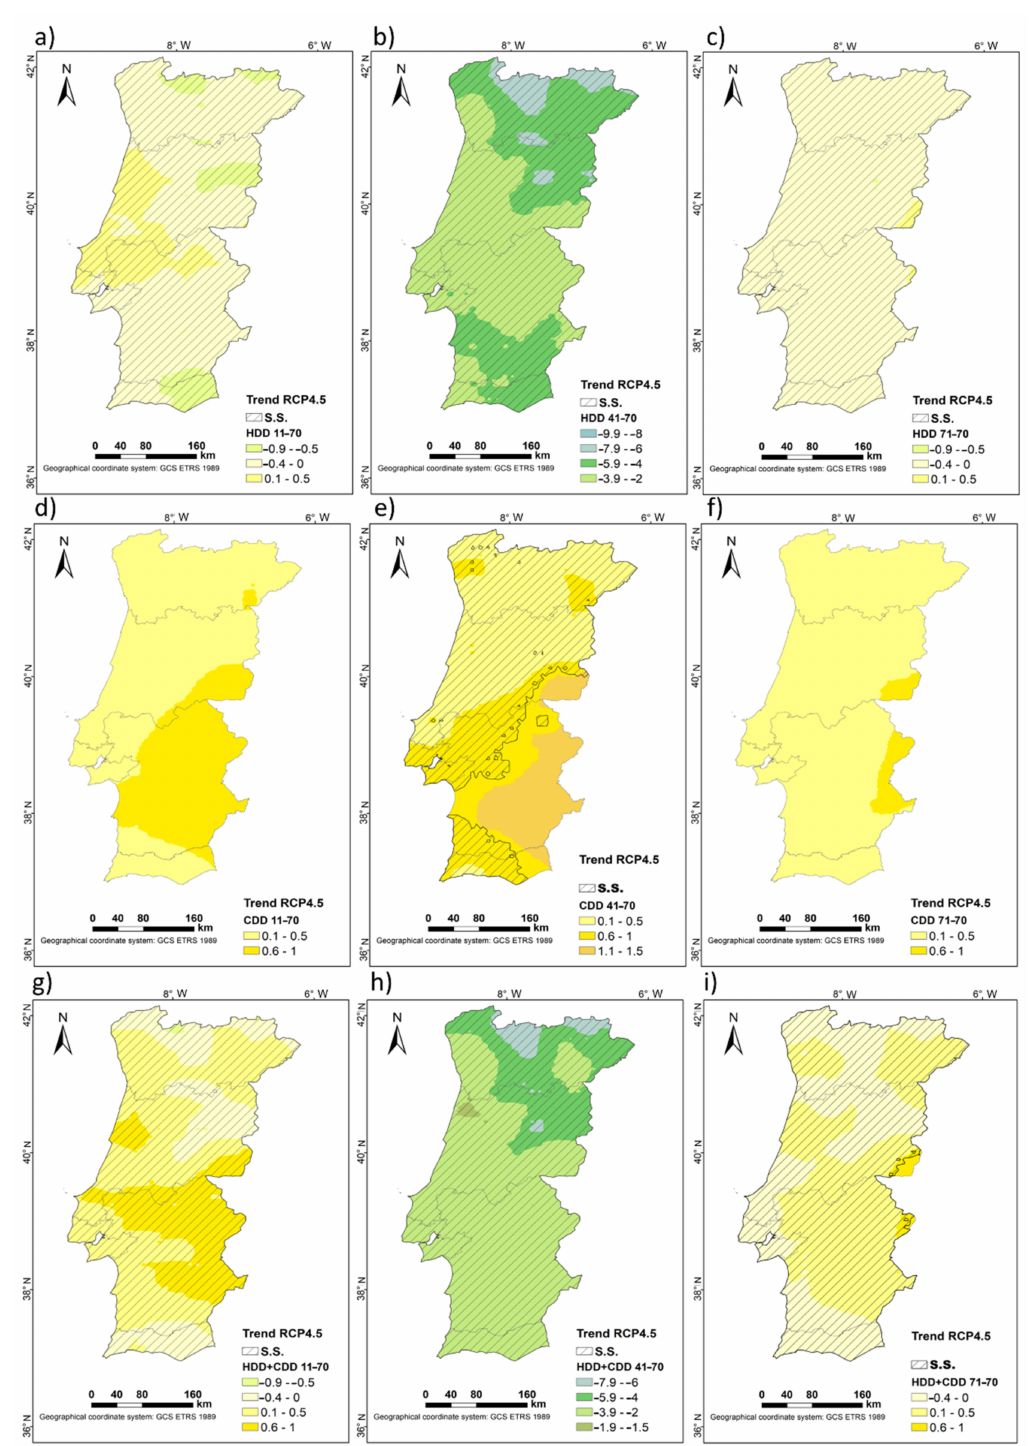
Figure 8. Statistically significant (S.S.) linear trends (at a 95% confidence level) of ( a – c ) HDD per year, ( d – f ) CDD per year, and ( g , h , i ) HDD + CDD per year under RCP4.5 for 2011–2070 (left), 2041–2070 (center) and 1971–2070